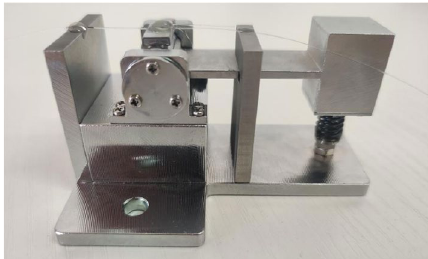
Figure 8. Physical prototype of FBG acceleration sensor.